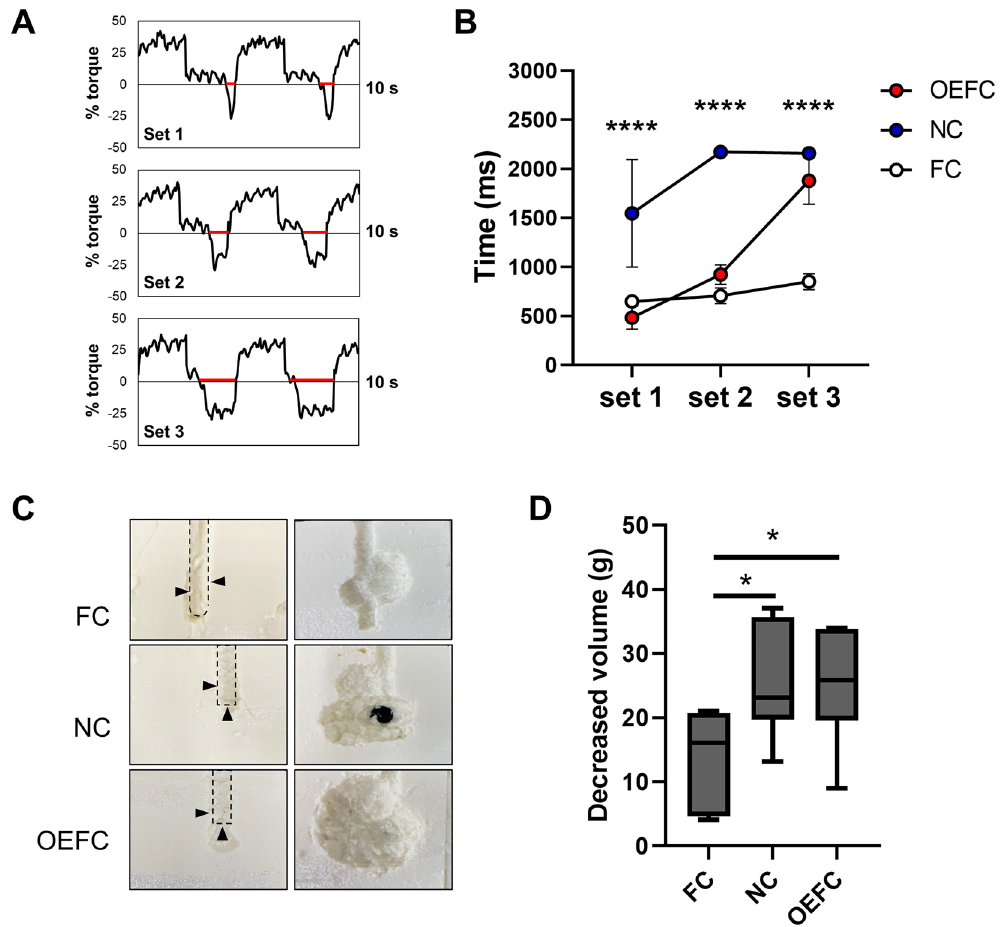
Figure 5. MBW under constant speed. ( A ) Images of the output waveform of the required force (% torque) when the operation was performed using OEFC at 20 mm/s in PBC. Red line shows the time during which the force was required in the minus direction. ( B ) The time to apply the force in the minus direction for each set (n = 6). ( C ) Images of cross sections of PBC before (left side) and after (right side) the three sets of the operations. ( D ) Decreased volume of PBC after the three sets of the operations (n = 6). Black arrows indicate the location of each